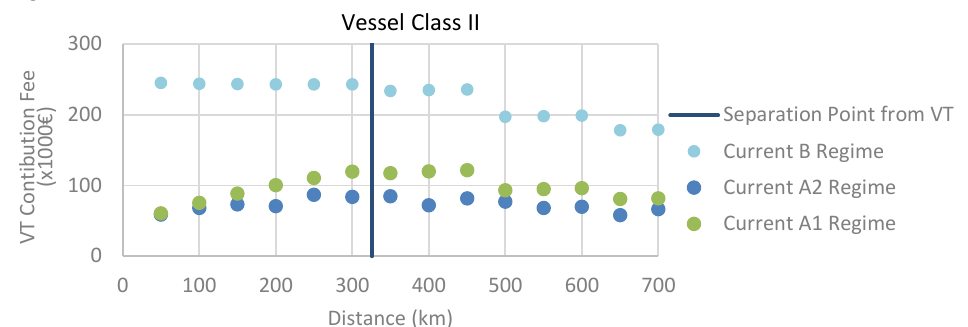
Figure 6: VT Contribution Cost Plots For Vessel Class V and IV